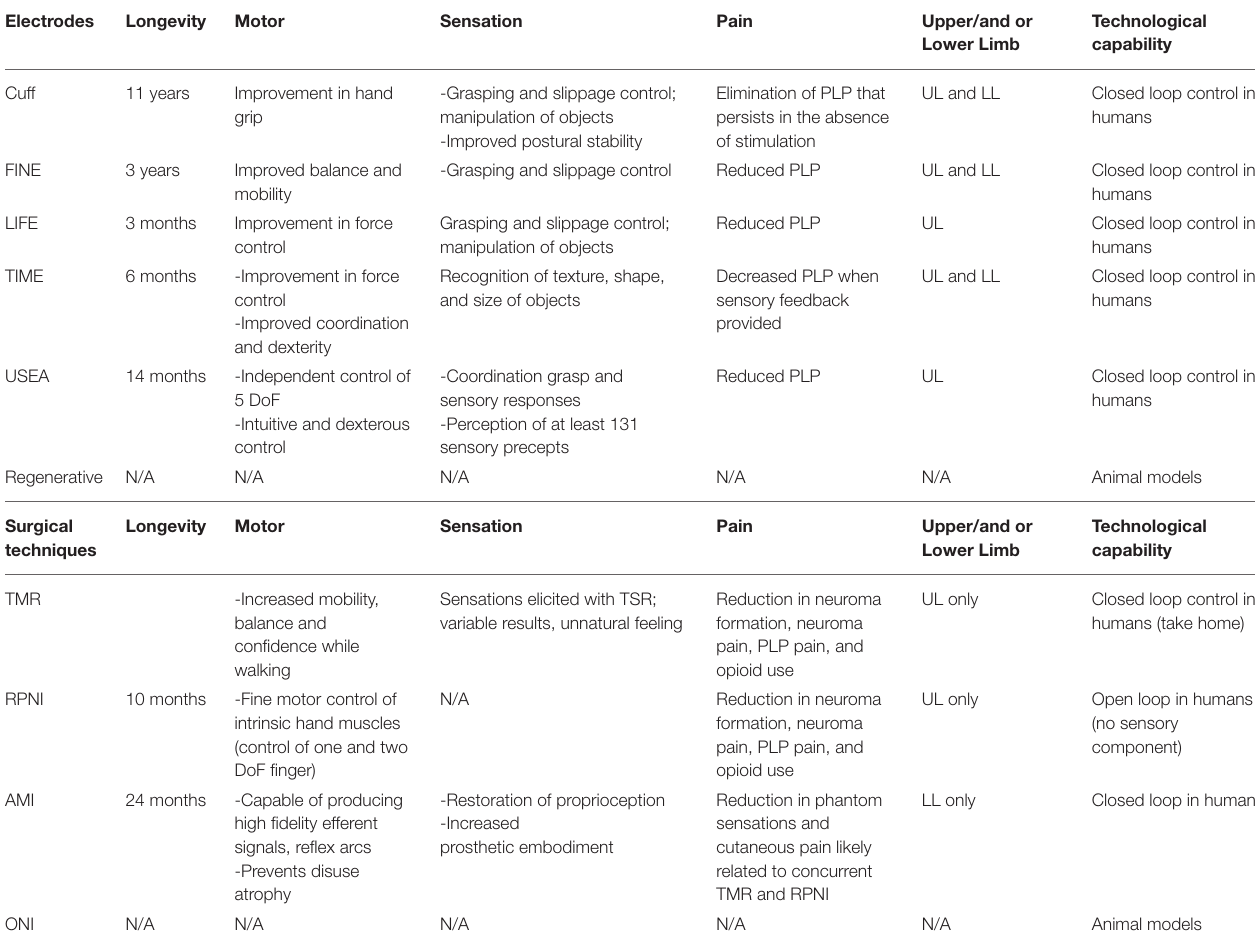
TABLE 1 | Characteristics of the electrodes and surgical techniques.